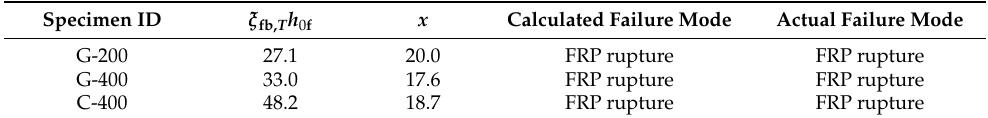
Table 9. Calculated ξ fb, T h 0f , x values and failure modes of tested beam specimens after high- temperature exposure.